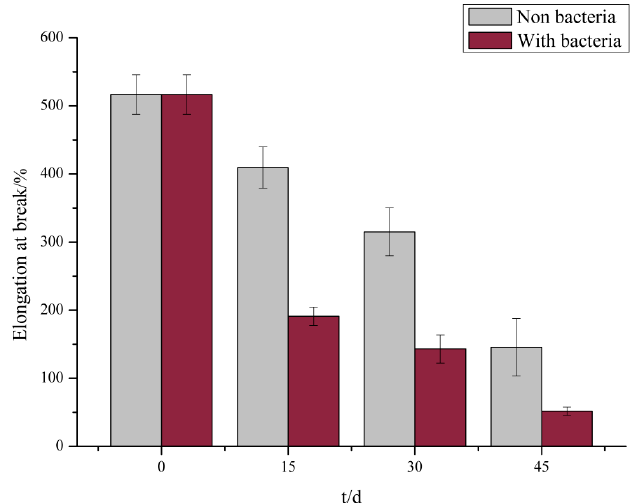
Figure 3. Measured results of elongation at break of membrane control group and experimental group.